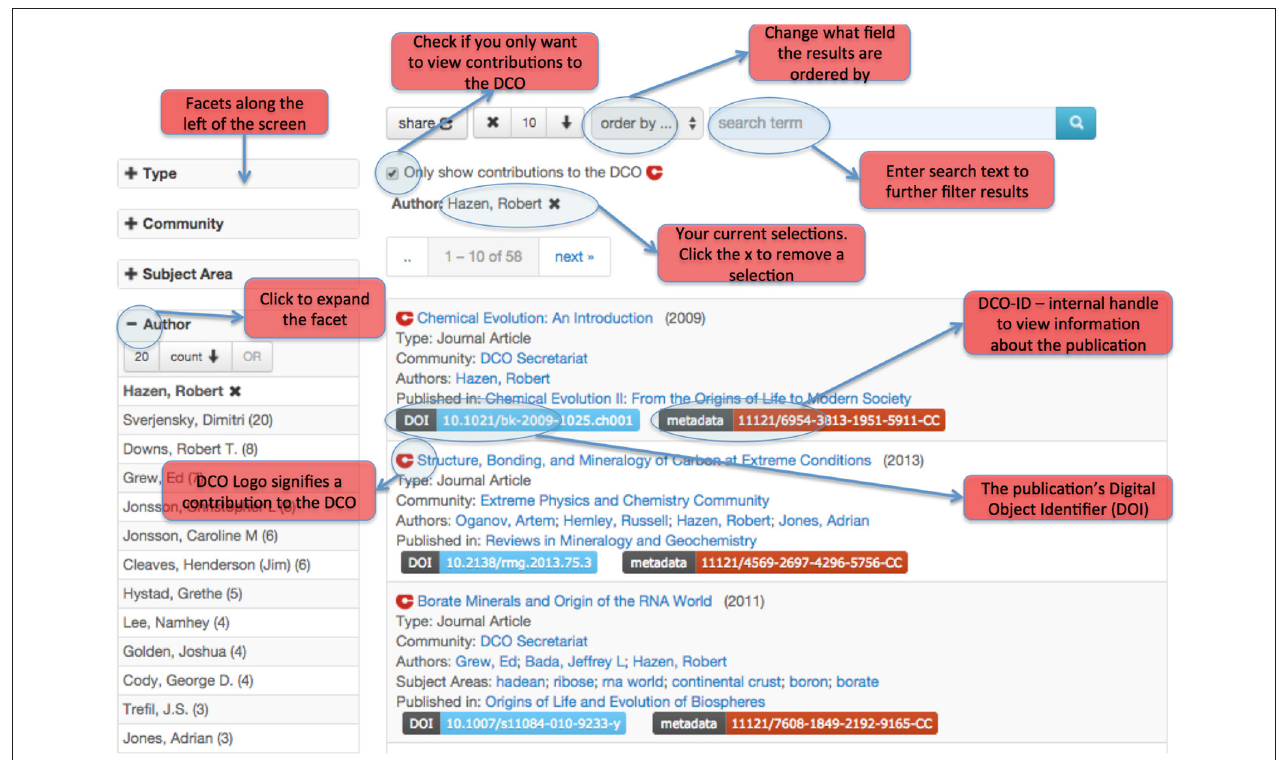
FIGURE 4 | A faceted browser for DCO publications (https://info.deepcarbon.net/vivo/publications).